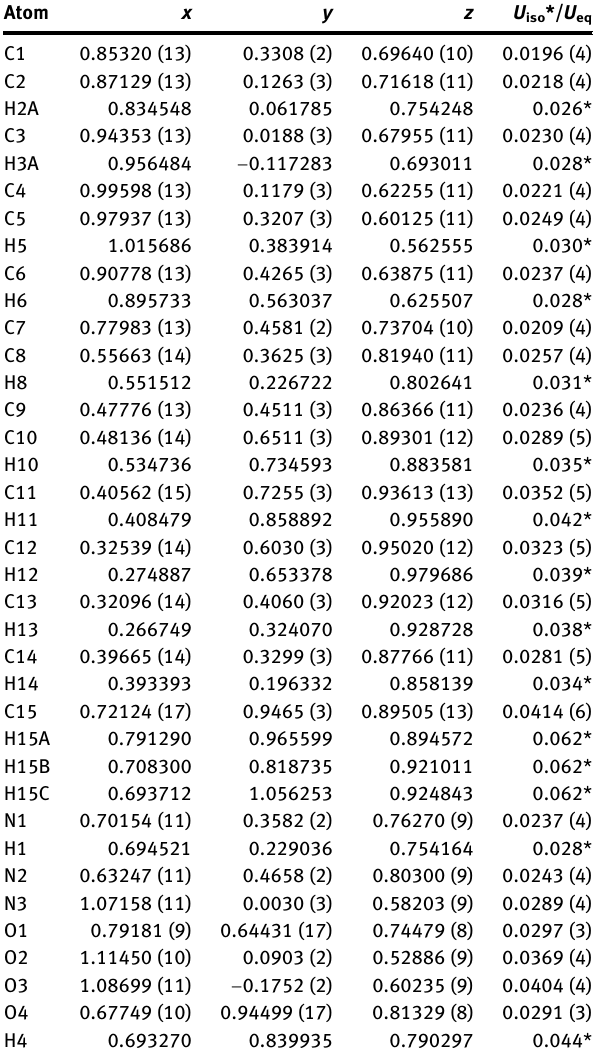
Table  : Fractional atomic coordinates and isotropic or equivalent isotropic displacement parameters (Å 